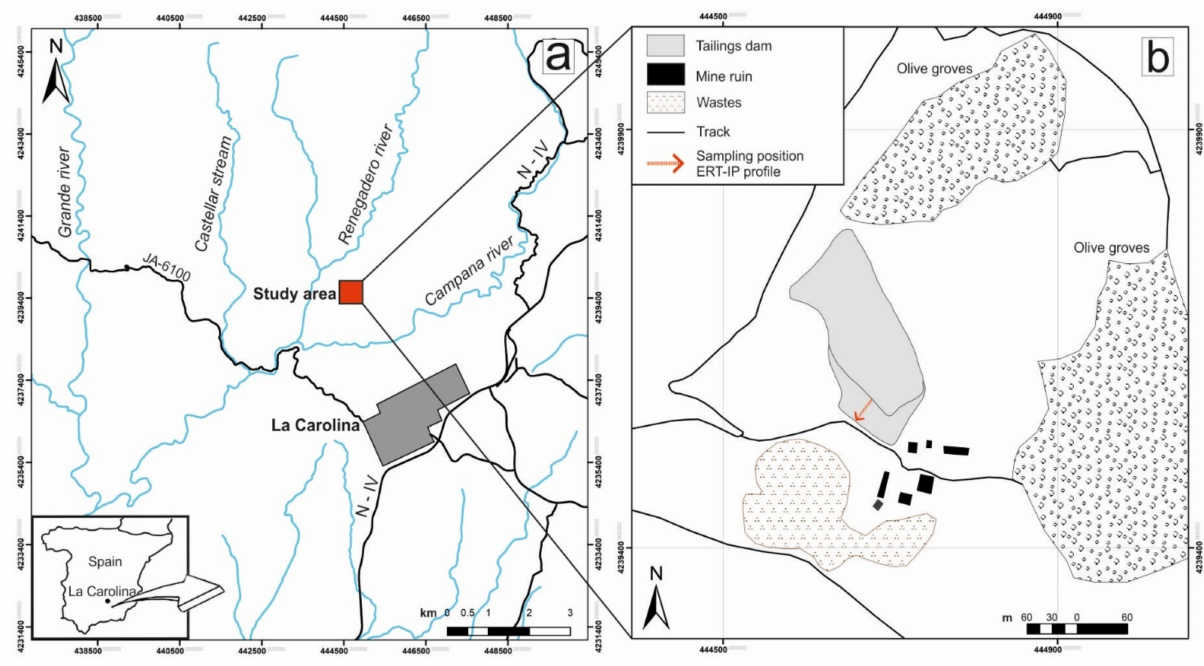
Figure 1. ( a ) Georeferenced location of the study area (ETRS89/UTM zone 30N). ( b ) Location of the tailing dam in the Federico mine, indicating the position along the slope of the ERT-IP